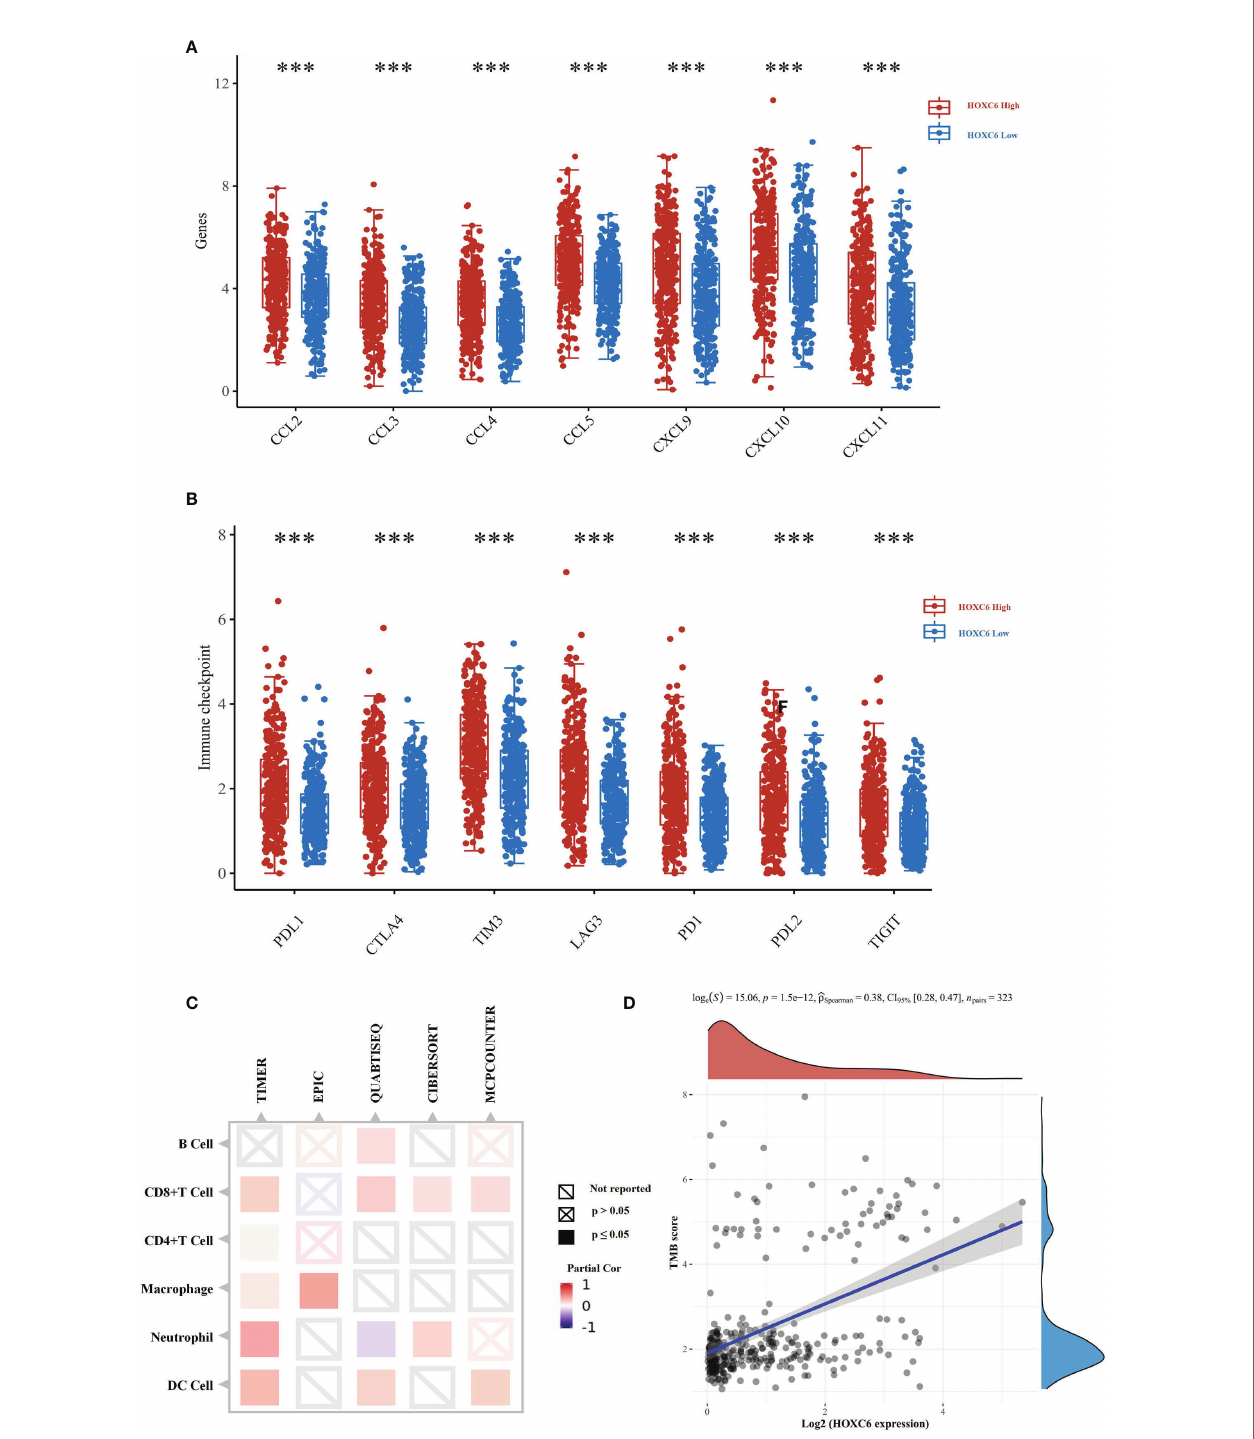
FIGURE 5 | TCGA veri fi cation of the effect of upregulated HOXC6 on the tumor immune microenvironment in CRC. (A) The expression of T cell attractive chemokines was signi fi cantly upregulated in the HOXC6 high-expression group compared to the low-expression group. (B) The expression of immune checkpoint molecules was signi fi cantly upregulated in the HOXC6 high-expression group compared to the low-expression group. (C) Expression of HOXC6 had a signi fi cantly positive correlation with the in fi ltration ratio of various immune cells using different algorithms. (D) Expression of HOXC6 had a signi fi cantly positive correlation with TMB score ( P <0.001, R=0.36). *** P <